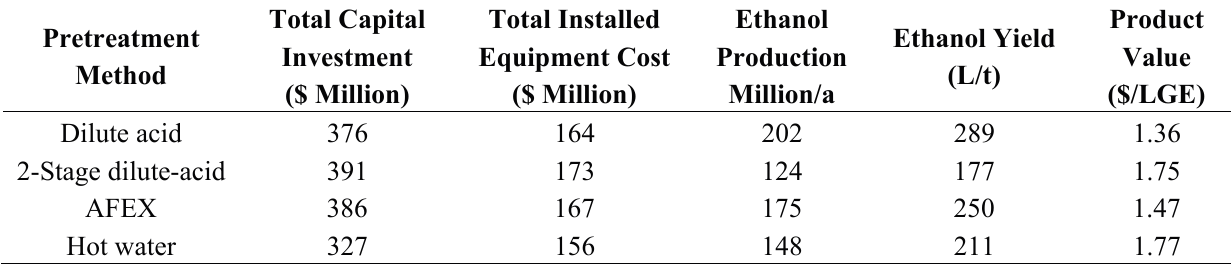
Table 2. Techno-economic analysis for each pretreatment technology. Adapted from [65] with permission form Elsevier, copyright